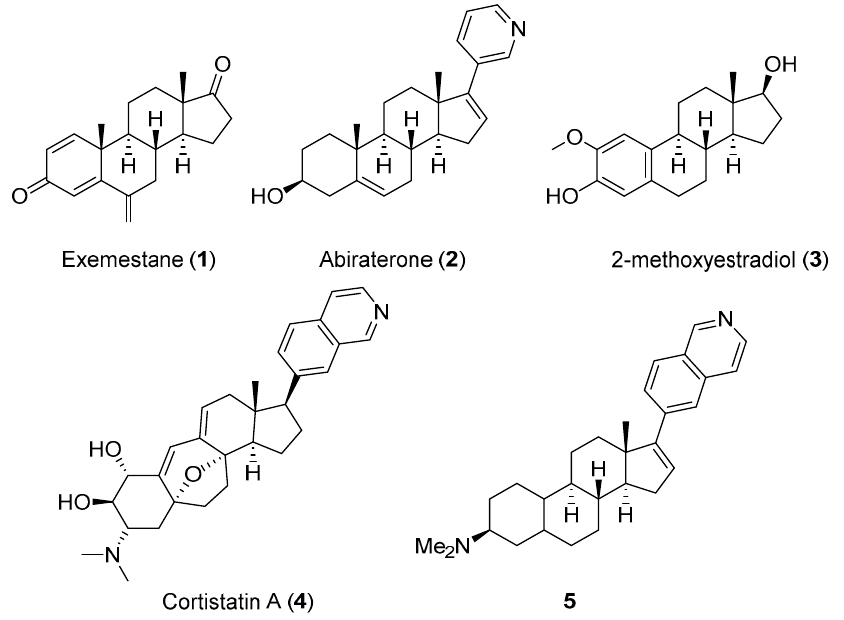
Figure 1. Chemical structures of biological active steroidal compounds.